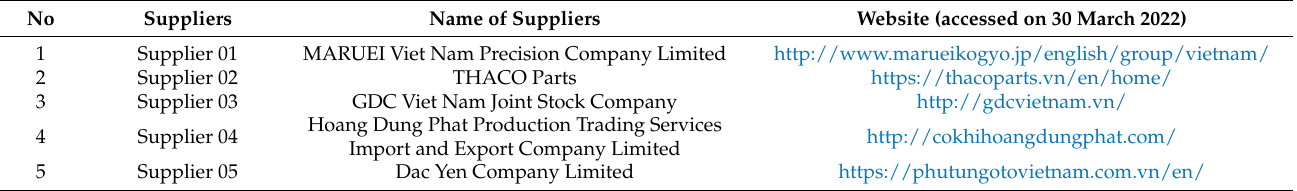
Table 4. The list of suppliers.